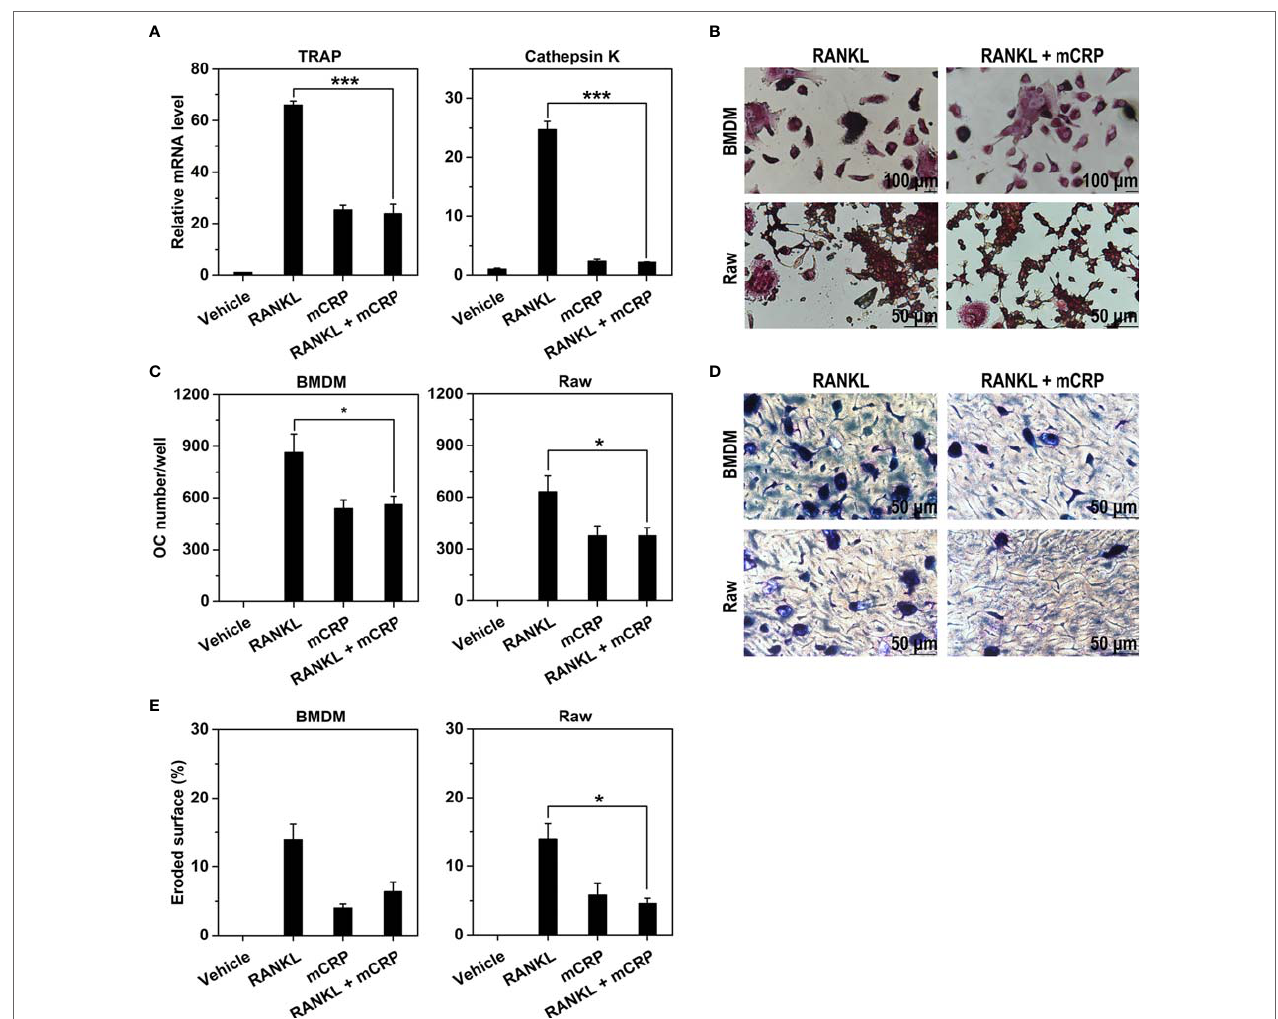
FigUre 4 | mCRP neutralizes the effects of receptor activator of NF- κ B ligand (RANKL). Bone marrow-derived macrophages (BMDMs) were treated with 10 ng/mL of M-CSF and 50 ng/ml RANKL in the presence or absence of 100 µg/mL of mCRP. After treatment for 2 days, the expression of TRAP and Cathepsin K were determined by q-PCR (a) . After treatment for 6 days, cells were stained for TRAP (B) and counted for the number of osteoclasts (c) . Their bone resorption activities were evaluated by toluidine blue staining (D) and the quantification of eroded surface (e) . The potent effects of RANKL on BMDMs were absent when treated together with mCRP. Comparable results were also obtained with Raw cells (B–e)